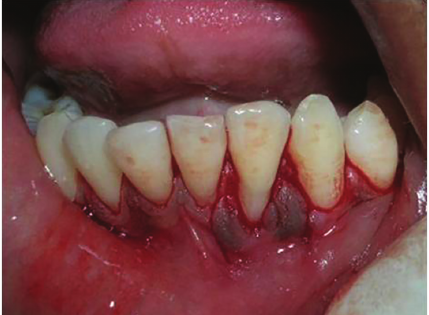
Figure 4: Intracrevicular incision followed by mesial and distal vertical releasing incisions for double papilla flap in relation to tooth number